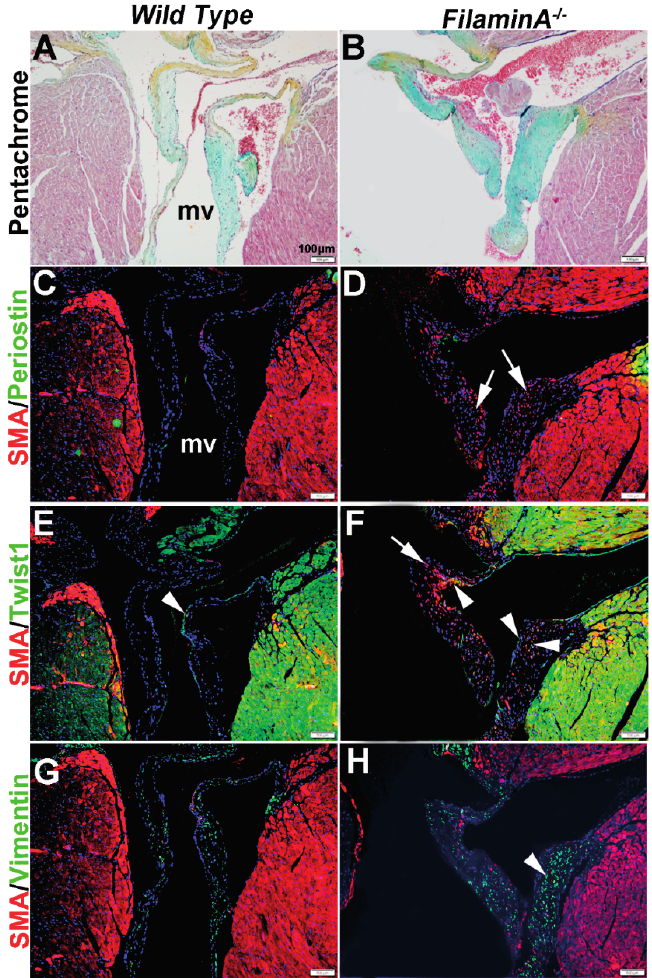
Figure 6. Characterization of VIC phenotypes in myxomatous mitral valves from 15 month old Filamin A − / − mice. Pentachrome staining to show extracellular matrix composition and organization in 15 month wild type ( Filamin A + /+ ) ( A ) and Filamin A − / − ( B ) mice. ( C – H ) Immunohistochemistry to detect expression of smooth muscle α -actin (SMA) with Periostin ( C , D ), Twist1 ( E , F ) and Vimentin ( G , H ) in cells within the mitral valve leaflet of wild type ( C , E , G ) and Filamin A − / − ( D , F , H ) mice. Arrows indicate SMA expression (red) and arrowheads indicate Twist1 ( E , F ) and Vimentin ( G , H ) shown in green. mv: mitral